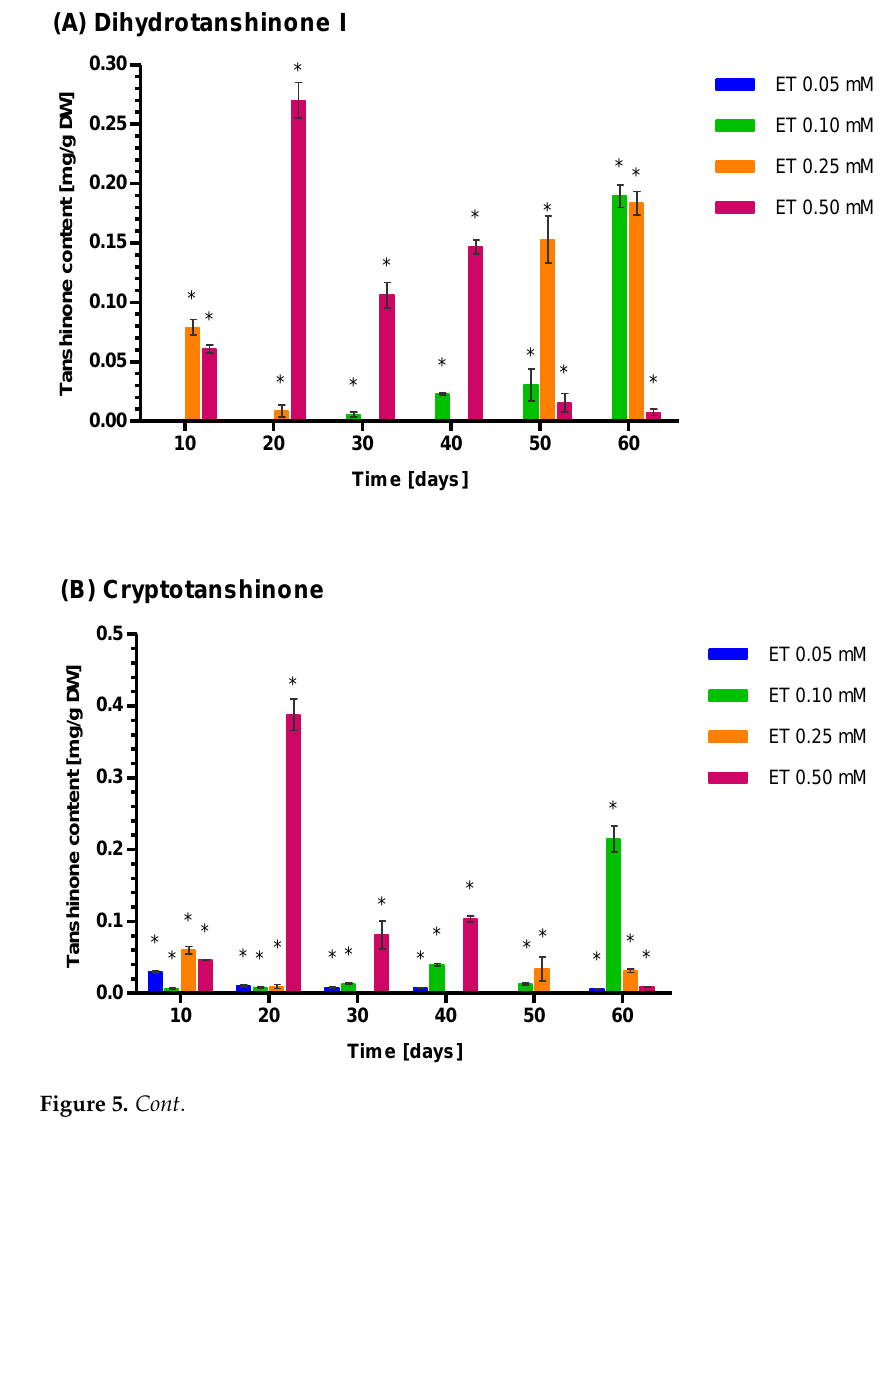
Figure 4. Concentration of three tanshinones dihydrotanshinone I ( A ), cryptotanshinone ( B ), DW) was noted after 60 days of exposure to 0.10 mM ET. The higher ET level (0.25 mM) tanshinone IIA ( C ), and total tanshinone ( D ) in S. miltiorrhiza callus presented as a function of yeast extract (YE) concentration (0.5, 2.0, and 4.0%) and elicitation time of 10 – 60 days. Control and tanhinone I values were not detectable. Differences between control (0) and non-zero tested samples were statistically significant according to the Wilcoxon signed-rank test at p < 0.01. Significant results of 0.67 ± 0.04 mg g − 1 DW mg after 20 days. Longer exposure to 0.50 mM ET gradually were marked by an asterisk (*). decreased Tt concentration to 0.26 ± 0.01 mg g − 1 DW.